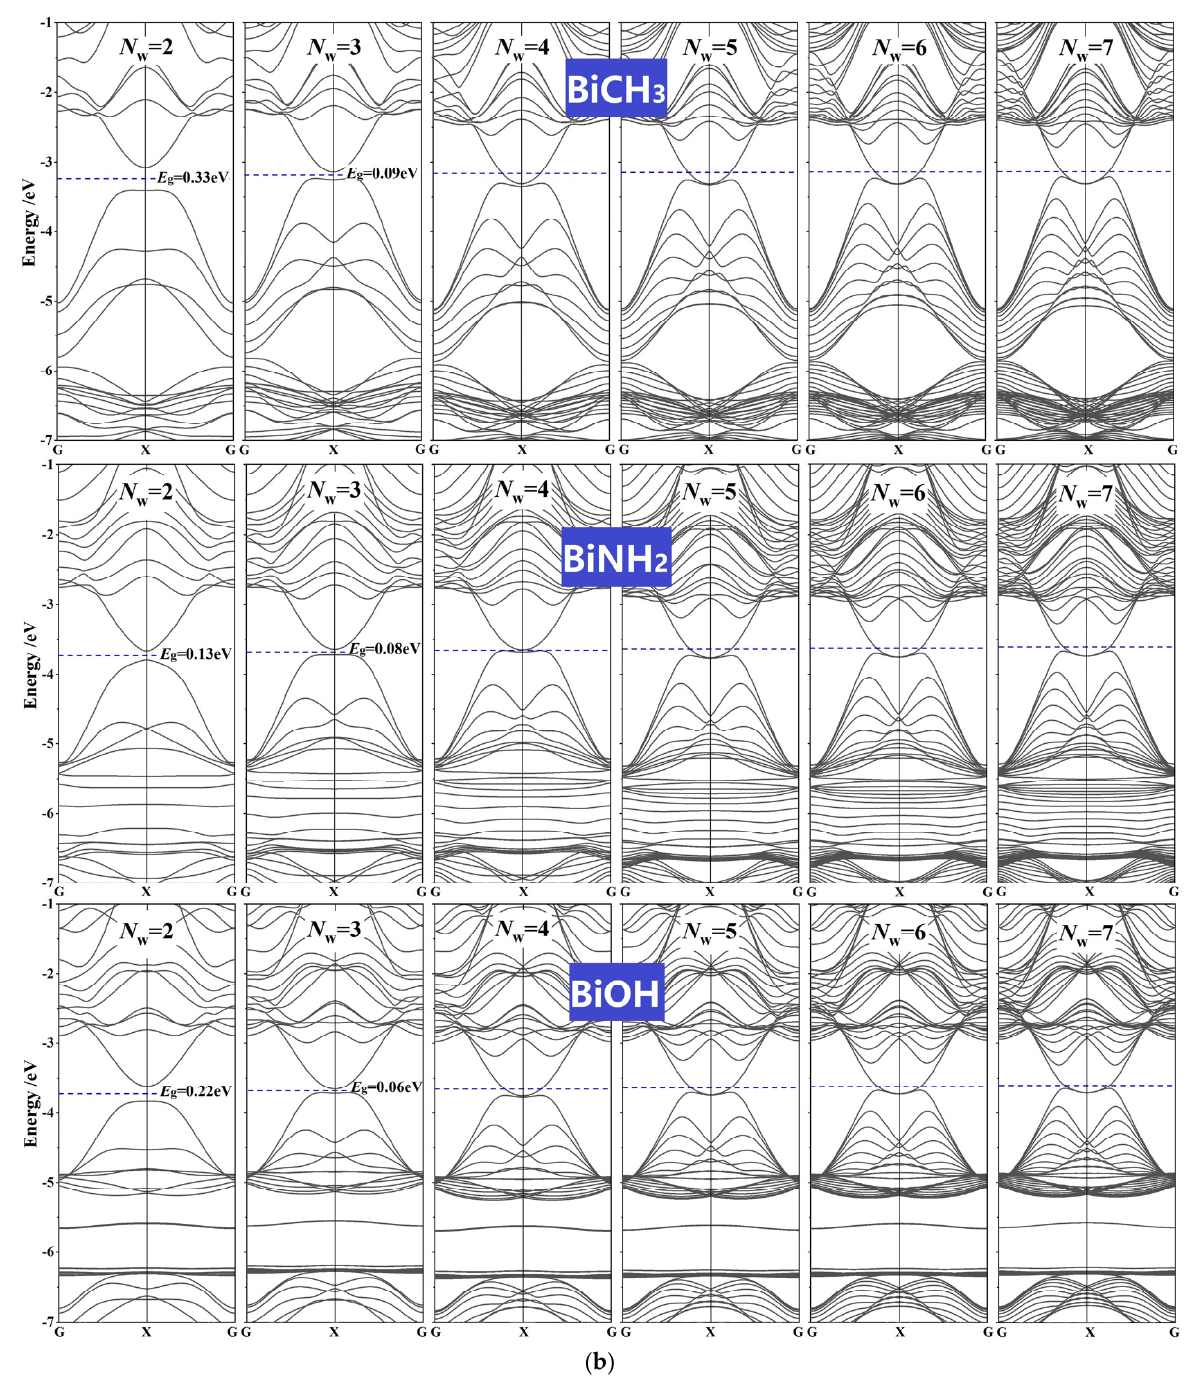
Figure 3. Band structures of ( a ) SbXH n and ( b ) BiXH n monolayer zigzag nanoribbons ( N w = 2~7) with their surfaces being chemically decorated by methyl, amino or hydroxyl group. Vacuum free electron energy is set as energy zero and Fermi level is indicated by horizontal dash line, and E g denotes energy band gap.